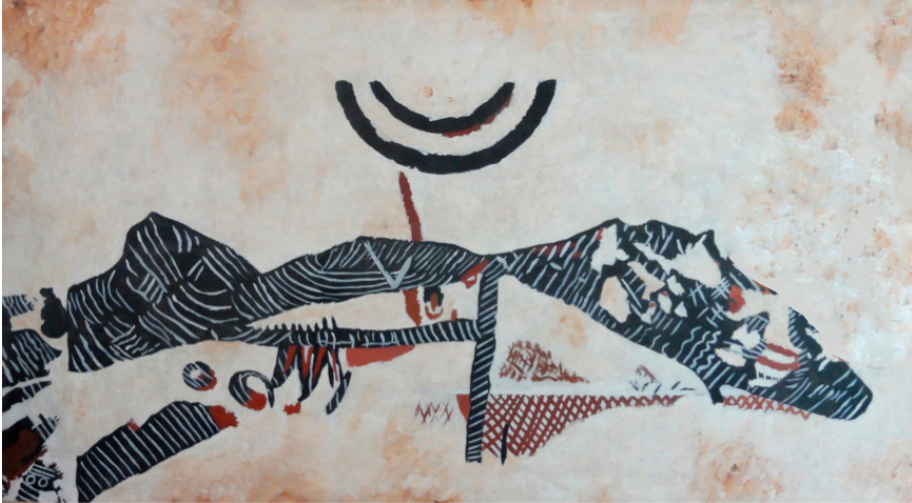
Figure 5. Revised Tiger/Landscape fresco (created by author).